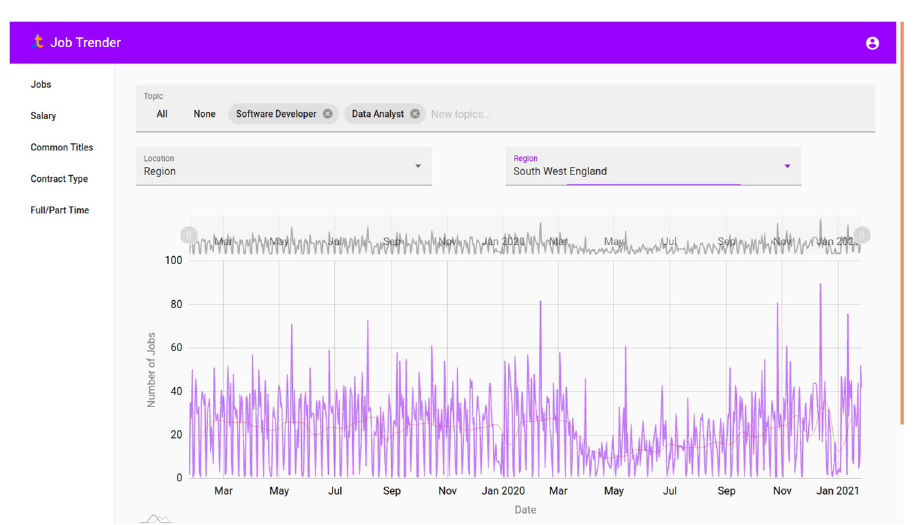
Fig 20. Job ads visualised with the online tool. Shown here are software and data jobs in the South West of England over the entire collection period.